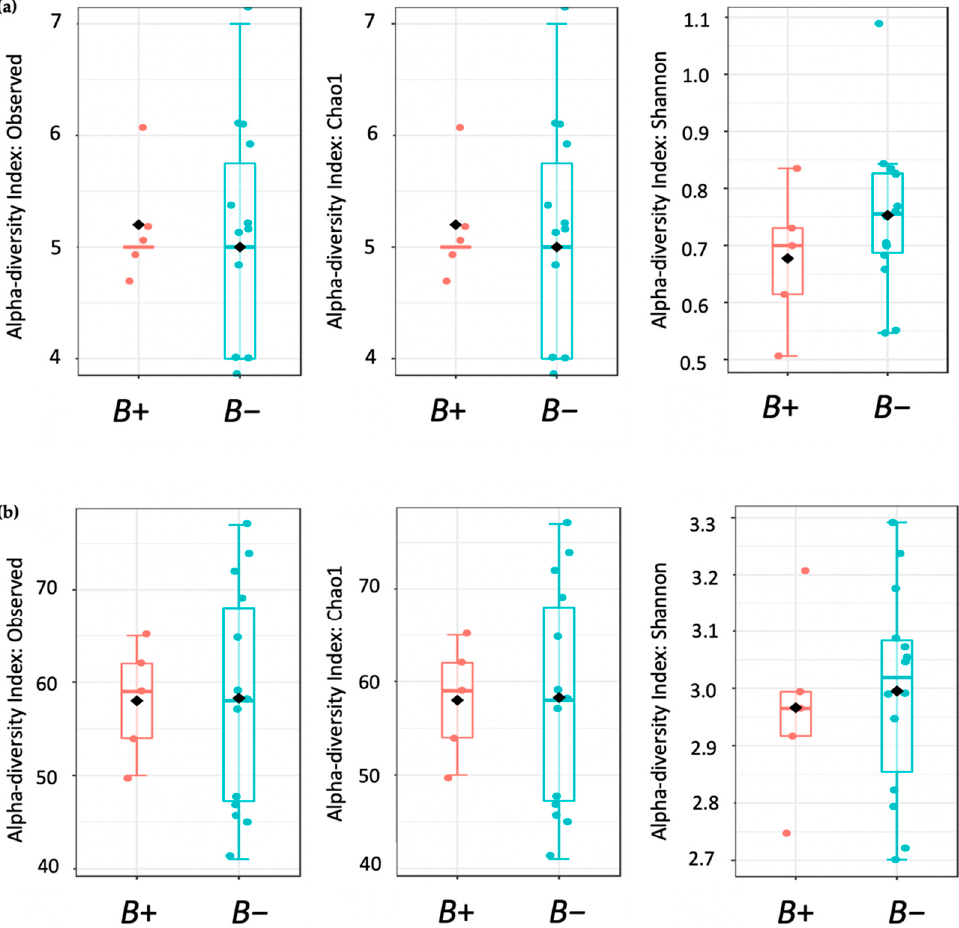
Figure 3. Boxplots showing alpha diversity (Observed, Chao1, and Shannon indices). Blue plots represent the negative ( B − ) samples and plots in red represent positive ( B +) voles. ( a ) Alpha diversity boxplots at the phylum level; ( b ) results at the genus level.